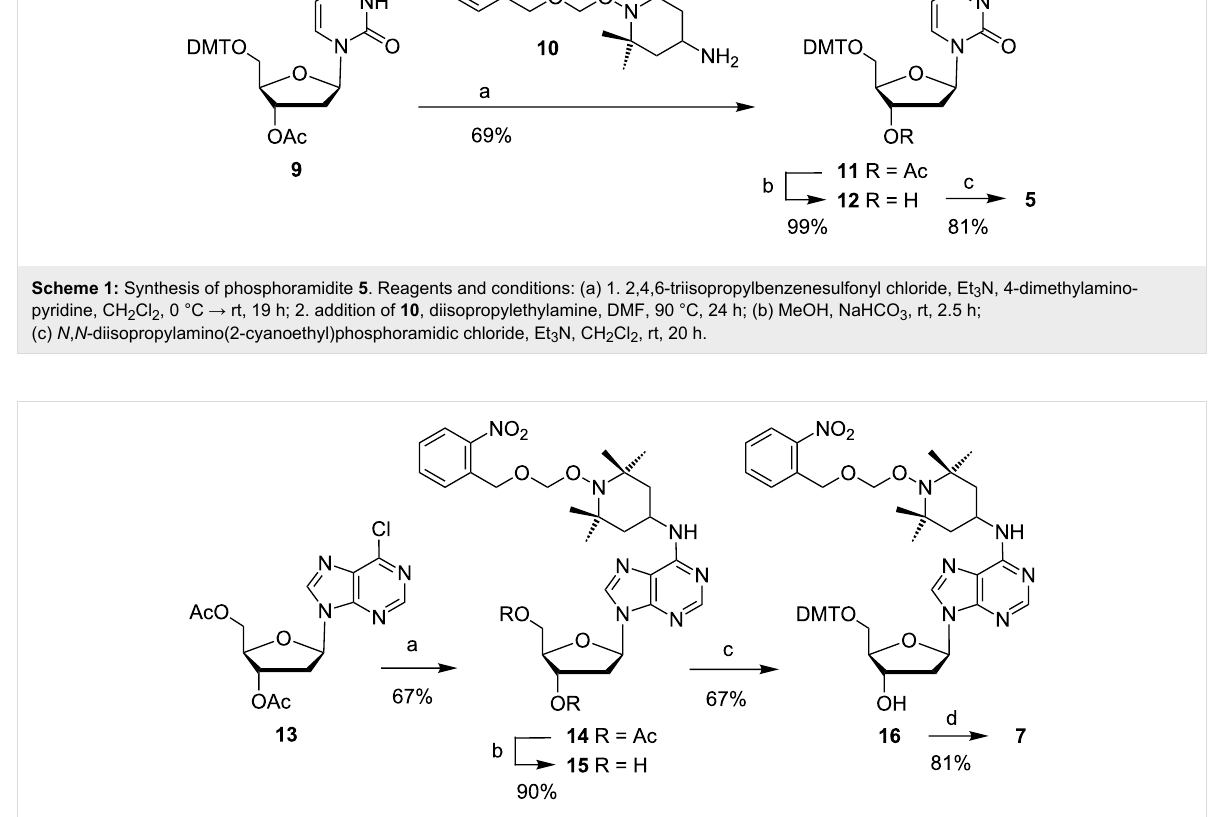
Scheme 2: Synthesis of phosphoramidite 7 . Reagents and conditions: (a) Addition of 10 , diisopropylethylamine, 1-propanol, 75 °C, 8 h, rt, 14 h; (b) 7 N NH 3 in MeOH, 0 °C → rt, 3 h; (c) dimethoxytrityl chloride, pyridine, rt, 23 h; (d) N , N -diisopropylamino(2-cyanoethyl)phosphoramidic chloride, Et 3 N, CH 2 Cl 2 , rt, 4.5 h.